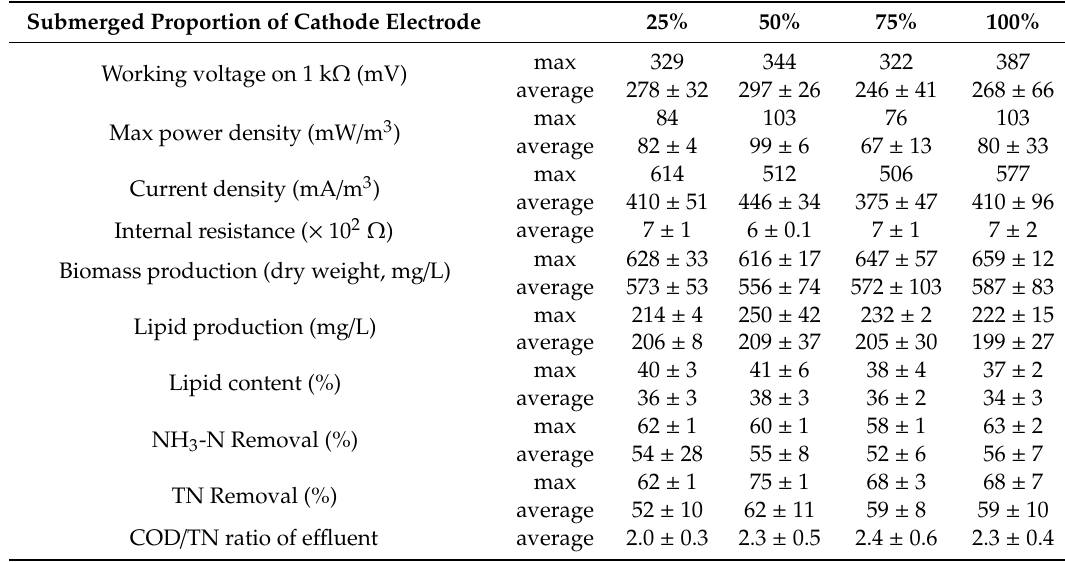
Table 1. Summary of the performances of the photosynthetic microalgae microbial fuel cells with the carbon cloth cathode electrodes submerged at the proportions of 25%, 50%, 75%, and 100%. Submerged Proportion of Cathode